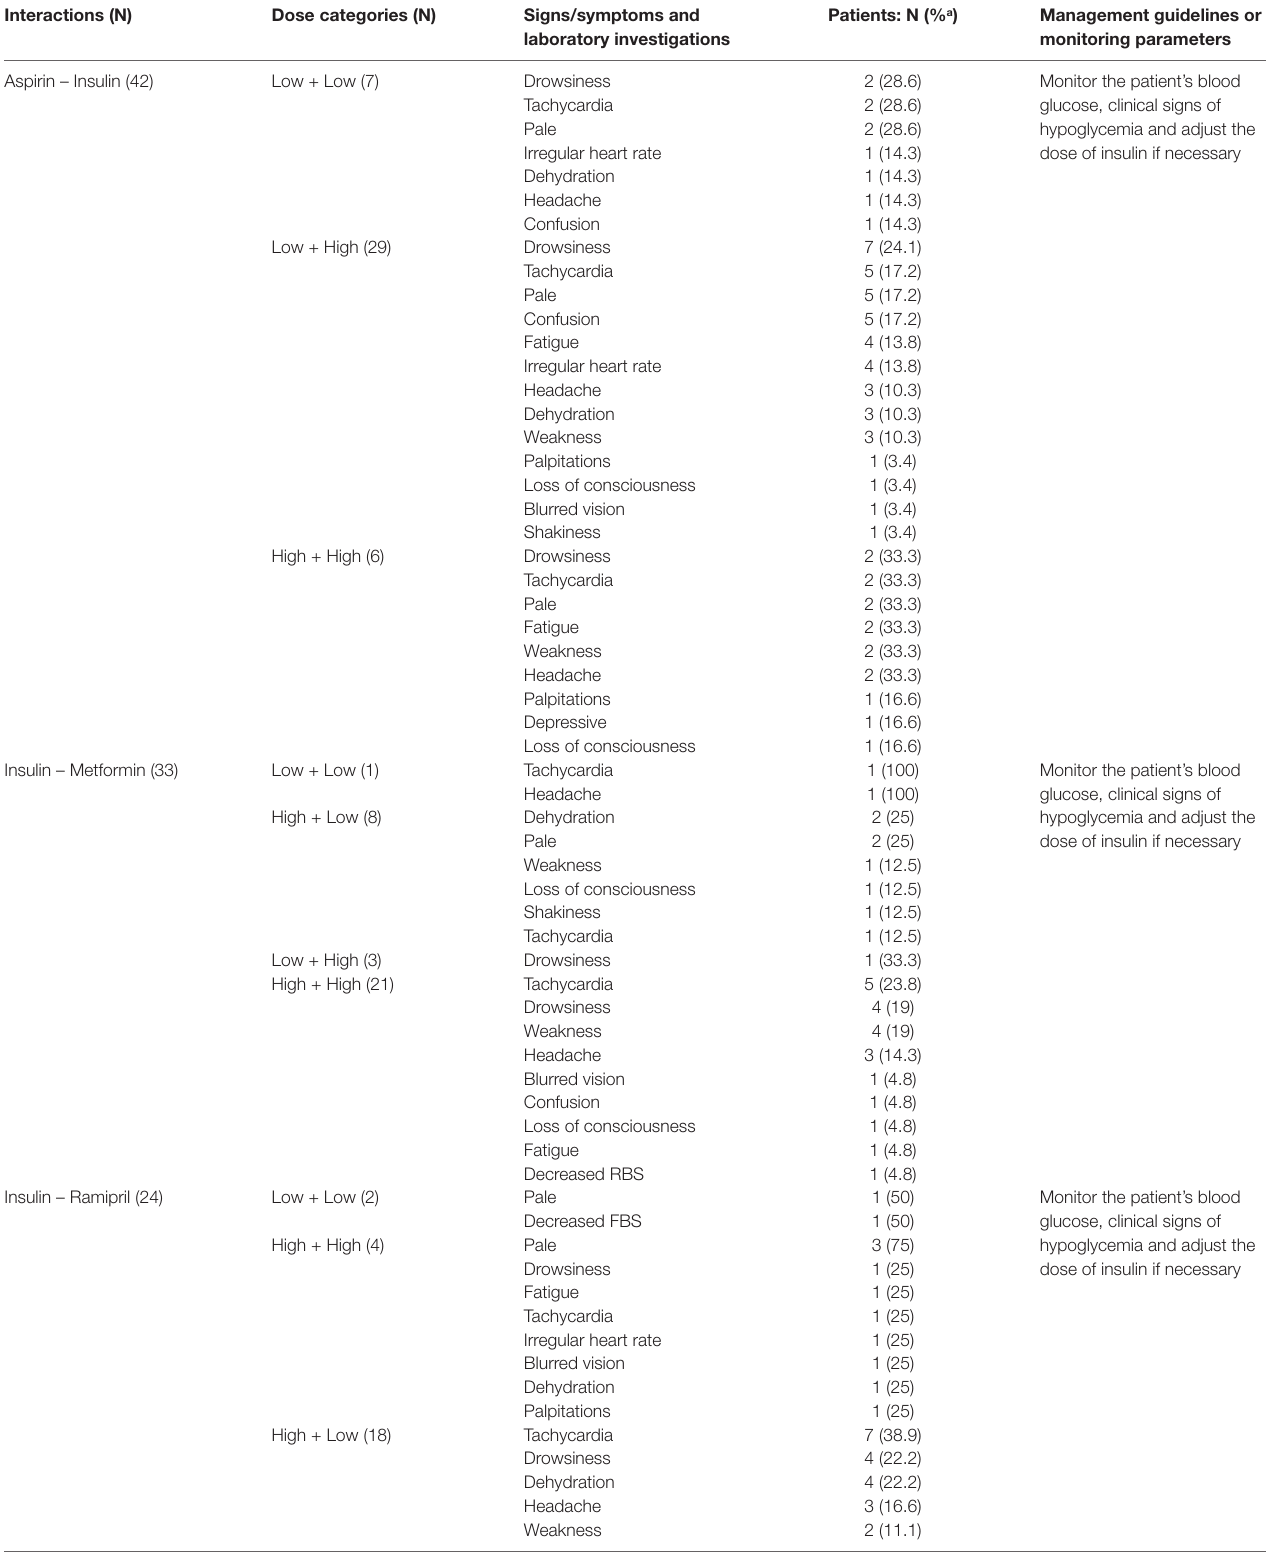
TABLE 4 | Clinical relevance of ten most frequent potential drug-drug